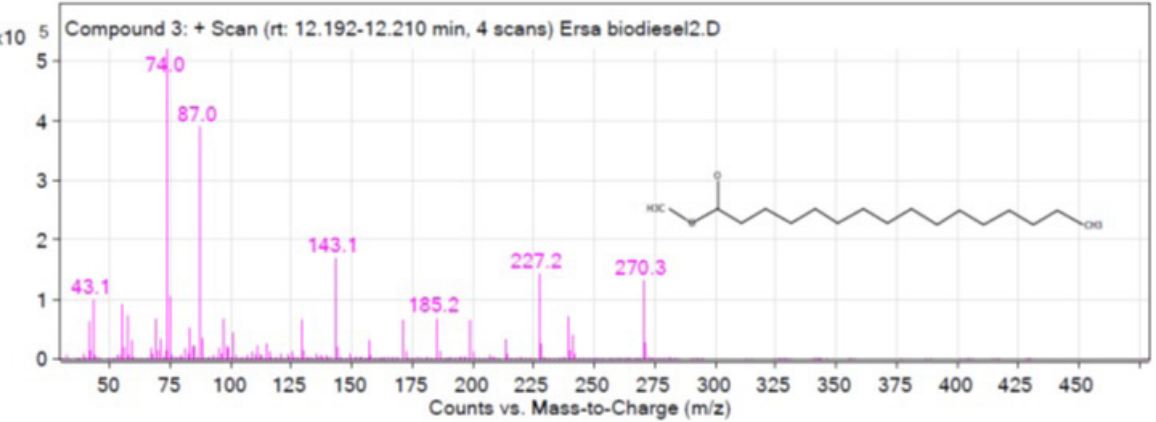
Figure 7: The MS spectrum of hexadecanoid methyl ester